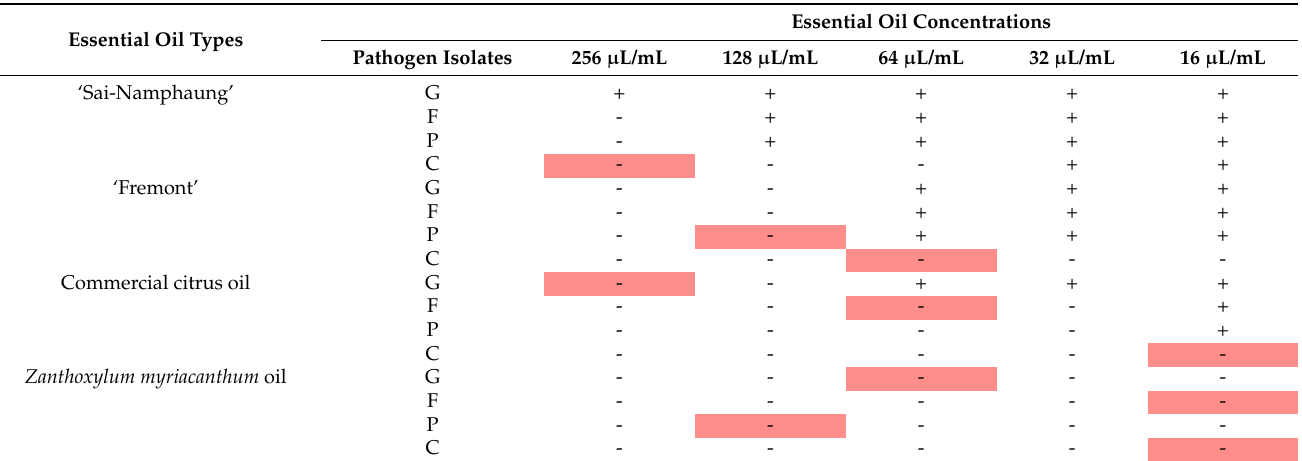
Table 3. Minimum inhibitory concentrations (MIC) and Minimum fungicidal concentrations (MFC)